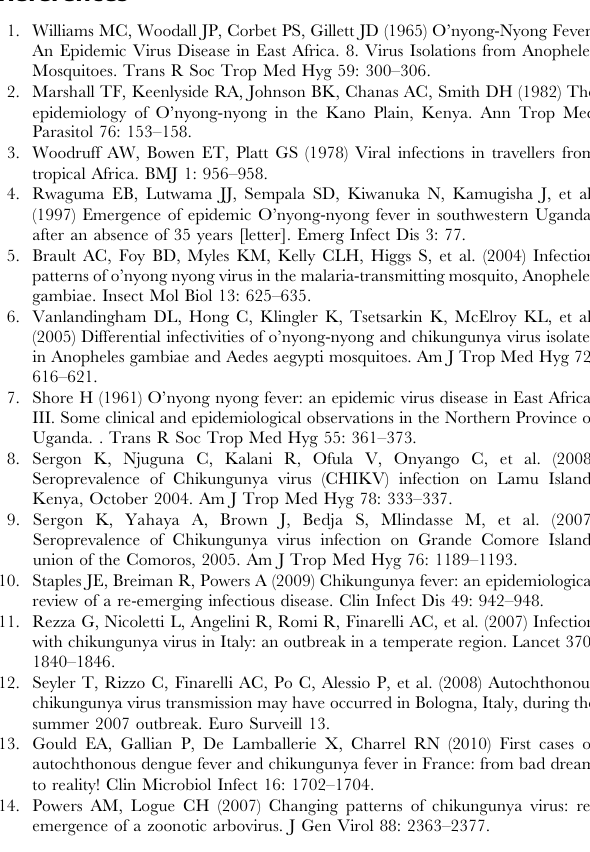
Figure S5 Products produced after digestion with appropriate type II restriction enzymes. These products were ligated to build the CHIKV/ONNV nsP3 cassette plasmid. (TIFF) Figure S6 Construction of final clone, Chik/Onn nsP3. CHIKV/ONNV nsP3 cassette plasmid and pCHIK.b were digested with SpeI and AvrII. The resulting products were ligated to generate the final clone with the complete ONNV nsP3 gene replacing the like gene in CHIKV. (TIFF) Protocol S1 Methods for construction of gene specific clones.